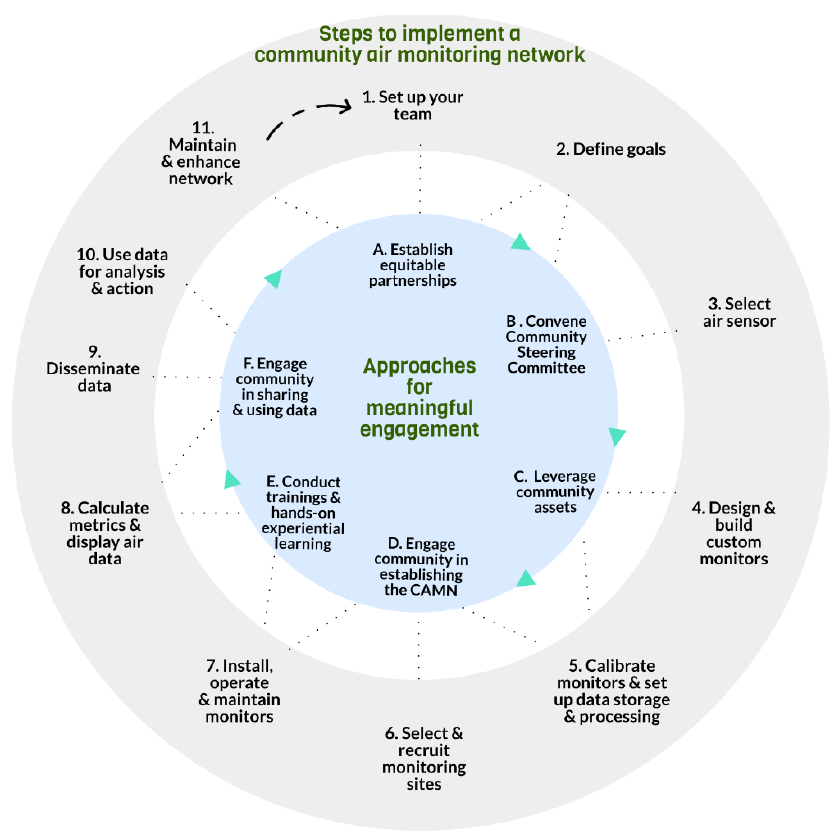
Figure 1. Model for meaningful community engagement in implementing the Imperial Project community air monitoring network (CAMN).